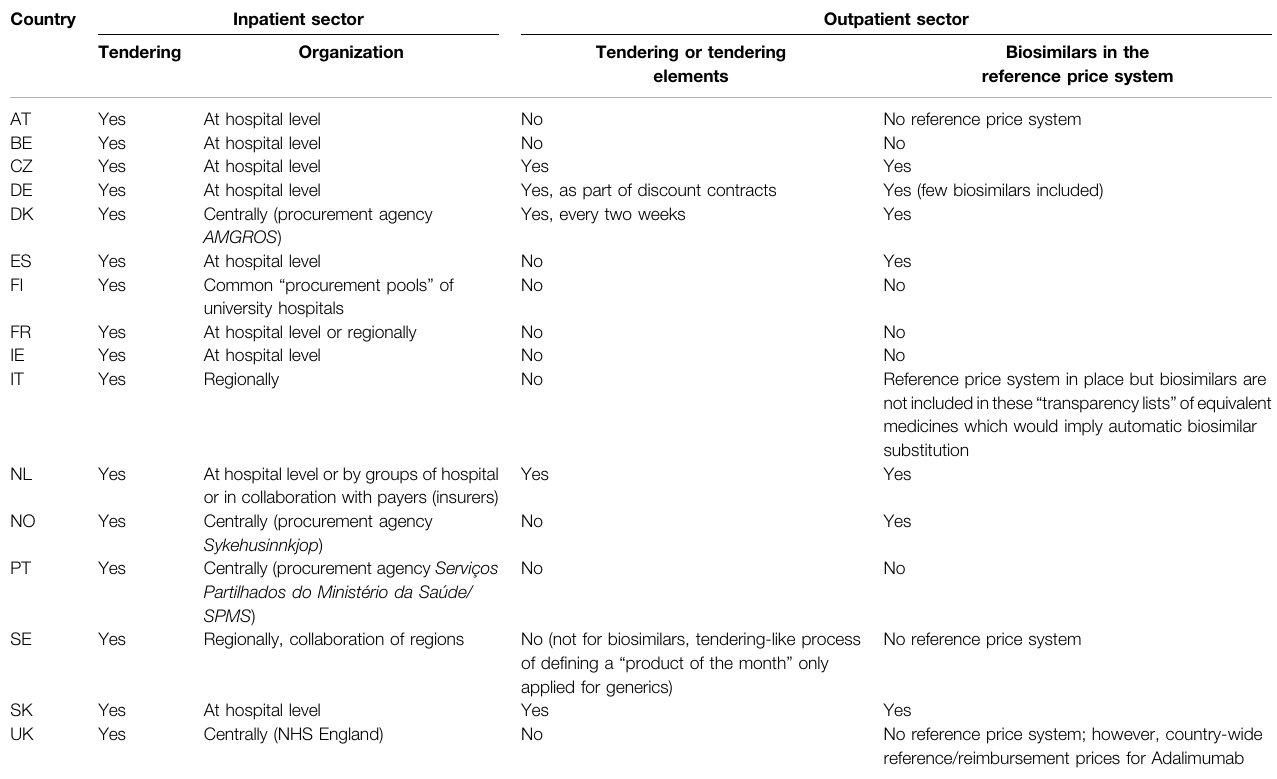
TABLE 3 | Role of tendering and internal reference pricing for biosimilar medicines.